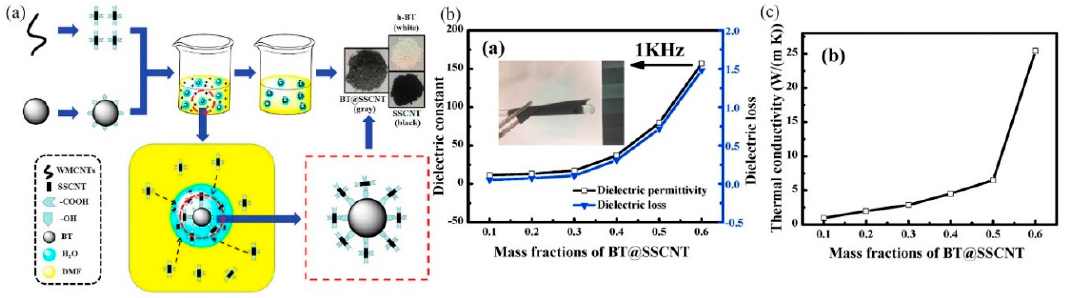
Figure 6. ( a ) Schematic diagram of the preparation of barium titanate@super short multiwalled carbon